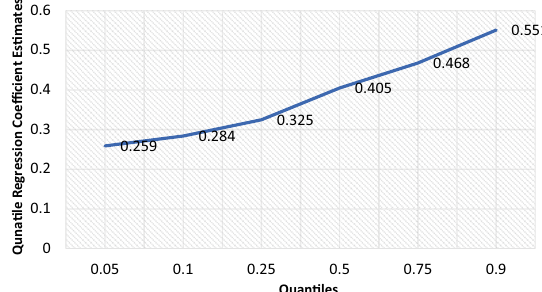
Fig. 10 Plot of coefficients of quantile regression for MIL_GDP and